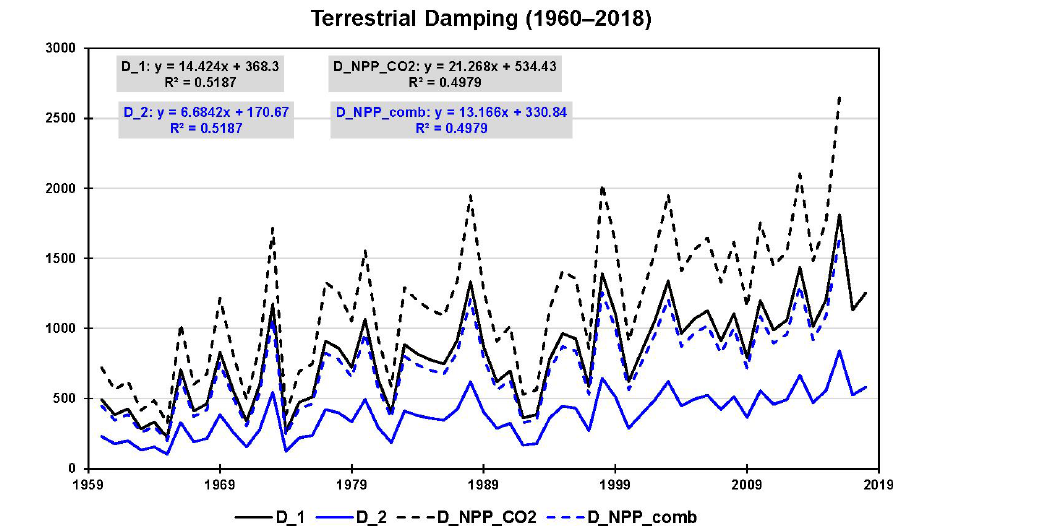
Figure 3. Terrestrial carbon uptake perceived as damping (in ppmvyr) based on the limits of leaf photosynthesis (1960–2018: D 1 and D 2 ) and on model-derived changes in net primary production (NPP; 1960–2016) due to the combined effect of CO 2 fertilization, nitrogen deposition, climate change, and carbon–nitrogen synergy ( D NPP_comb ) as well as CO 2 fertilization only ( D NPP_CO the four damping series are shown at the top. These are used to interpret damping as constants with appropriate uncertainty (given by half the maximal